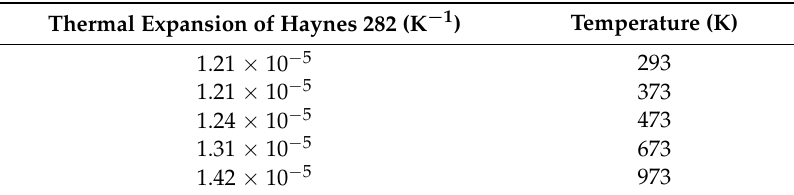
Table 8. Temperature dependence of thermal expansion for Haynes 282